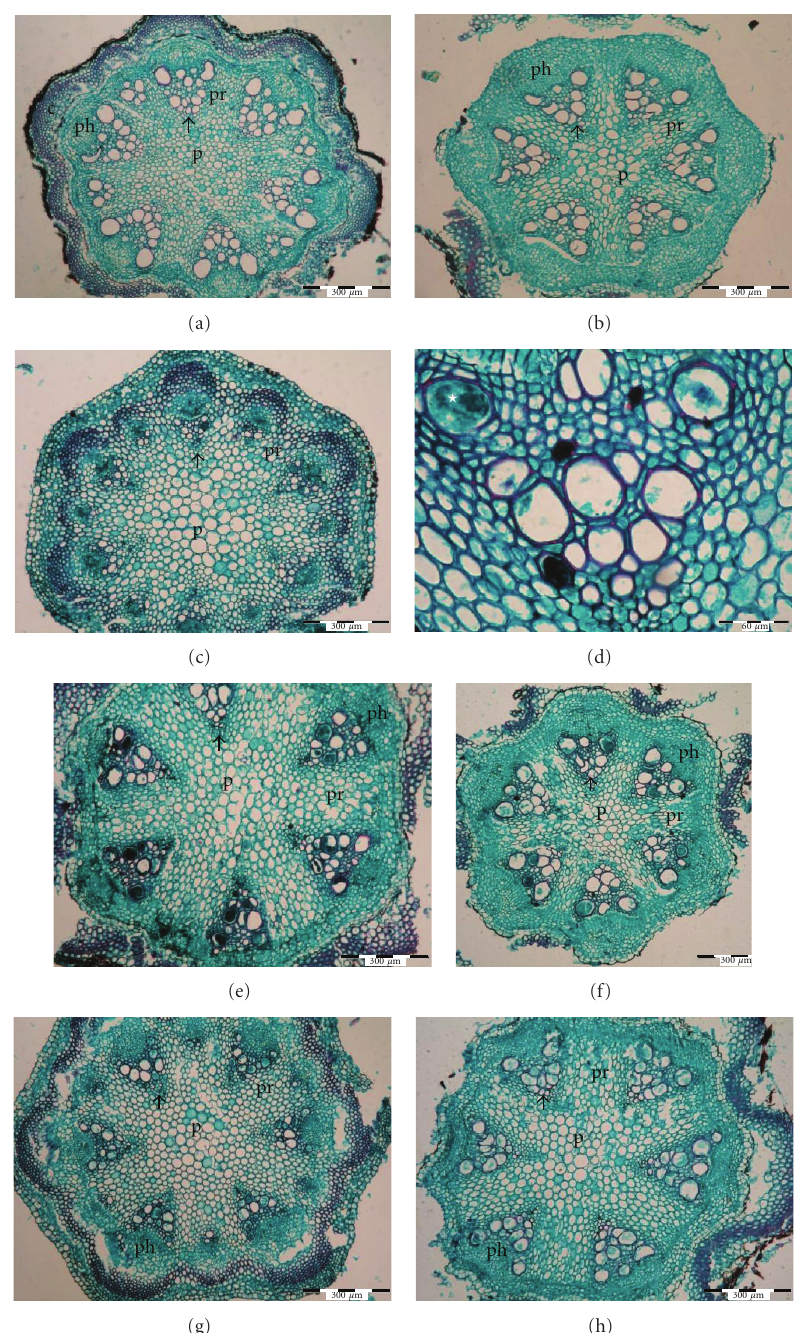
Figure 3: Identification of xylem occlusions in short-lasting (Andromeda) and long-lasting (Solidarno´s´c) cultivars of Clematis by staining with fast green and safranin. (a) and (b) Control stems with xylem vessels free of any occlusions in Andromeda (a) and Solidarno´s´c (b). (c) and (d) Stems kept in distilled water, term I with xylem vessels half and completely blocked by the occlusions in Andromeda (c) and Solidarno´s´c (d). (e) and (f) Stems kept in distilled water, term II with xylem vessels half and completely blocked by the occlusions in Andromeda (e) and Solidarno´s´c (f). (g) and (h) Stems kept in 8HQC + 2% sucrose, term II with xylem vessels half and completely blocked by the occlusions in Andromeda (g) and Solidarno´s´c (h). c: cortex with lamellar collenchyma, p: pith, pr: pith rays, ph: phloem, arrow: xylem vessel, ∗ : blocked xylem lumen. The choice of the cultivar was based on observations of the vase life length made by Skutnik and Rabiza-´Swider [1, 16] and previous anatomical observations of stems of 5 di ff erent cultivars. Two of them were characterized as short- lasting (“Andromeda”, “Viola”), one medium (“Isago”), and two long-lasting (“Solidarno´s´c” and “Silver moon”) cultivars. Control: term 0, term I: after 7 days of postharvest life (wilting of flowers kept in distilled water), term II: after 12 days, when wilting and loss of a decorative value occurred in flowers placed into the